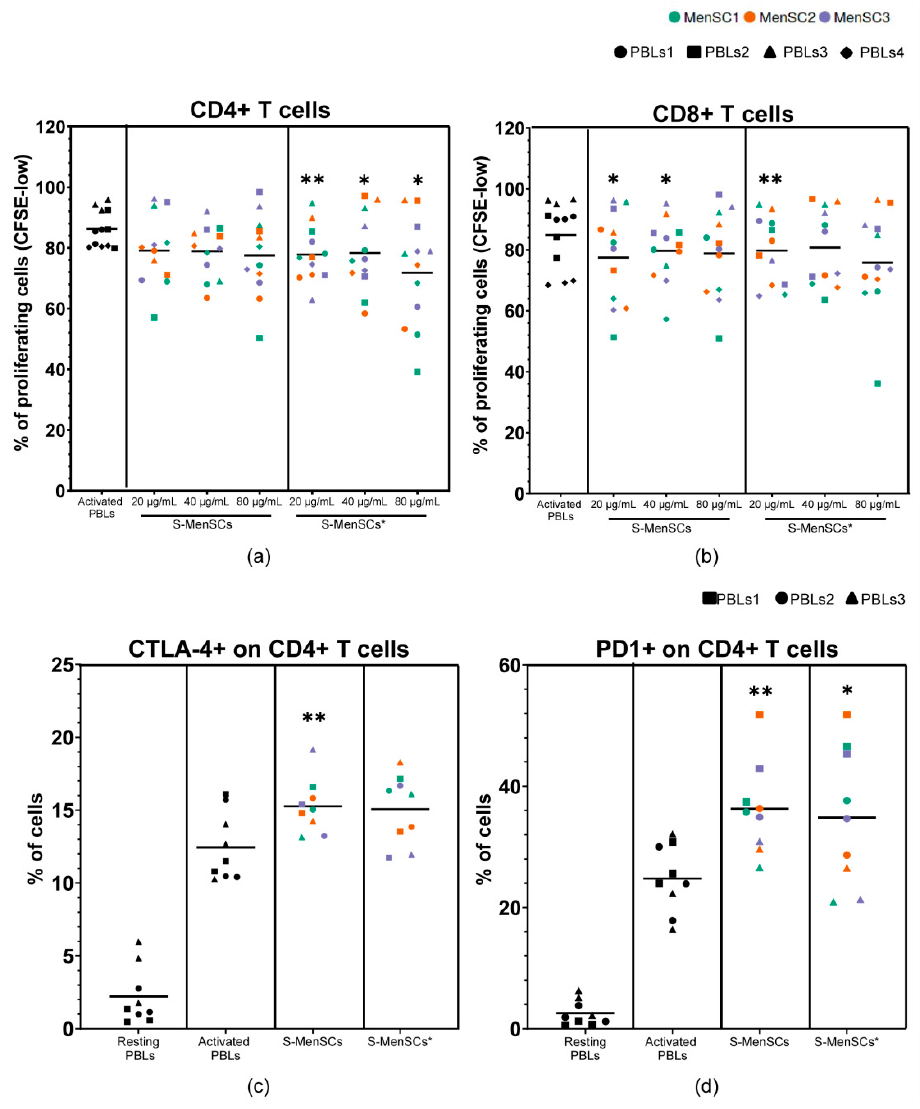
Figure 6. Lymphocyte activation assays for the evaluation of the immunomodulatory effect of S-MenSCs and S-MenSCs*. PBLs from healthy donors ( n = 3–4, different symbols) were activated and co-cultured with S-MenSCs and S-MenSCs* for 72 h ( n = 3, different colors). ( a ) Percentage of CD4+ cells and ( b ) percentage of CD8+ T cells with CFSE-low. ( c ) Percentage of CTLA-4 expression on CD4+ T cells. ( d ) Percentage of PD-1 expression on CD4+ T cells. Individual values are represented together with the mean. Data were analyzed by paired t -test against activated PBLs as matched controls. A p value was considered significant at * p < 0.05, ** p < 0.05. The immunomodulation assay was also focused on the regulation of immune checkpoints. The expression of these immune checkpoints was determined in CD4+ and CD8+ T cells. A significant increase in CTLA-4 was found in CD4+ T cells co-cultured with S-MenSCs ( p = 0.0093) but not with S-MenSCs*(Figure 6c). Additionally, both the S-MenSCs and S-MenSCs* (80 µg/mL) significantly increased the expression of PD-1 on CD4+ T cells ( p = 0.0015 and p = 0.0241, respectively) (Figure 6d). No significant differences were observed in CD8+ T cells (data not